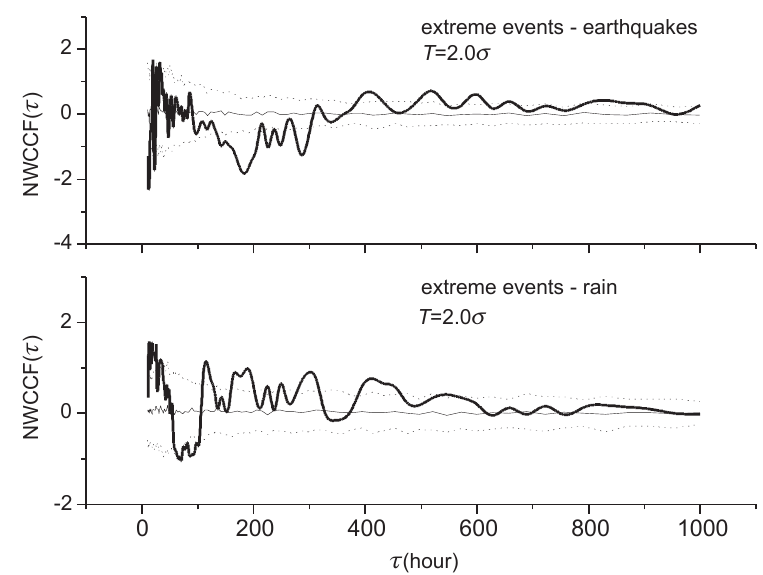
Fig. 4. NWCCF( τ ) ∼ τ relation for EE-EQ and EE-RR pairs, with T = 2.0 σ .